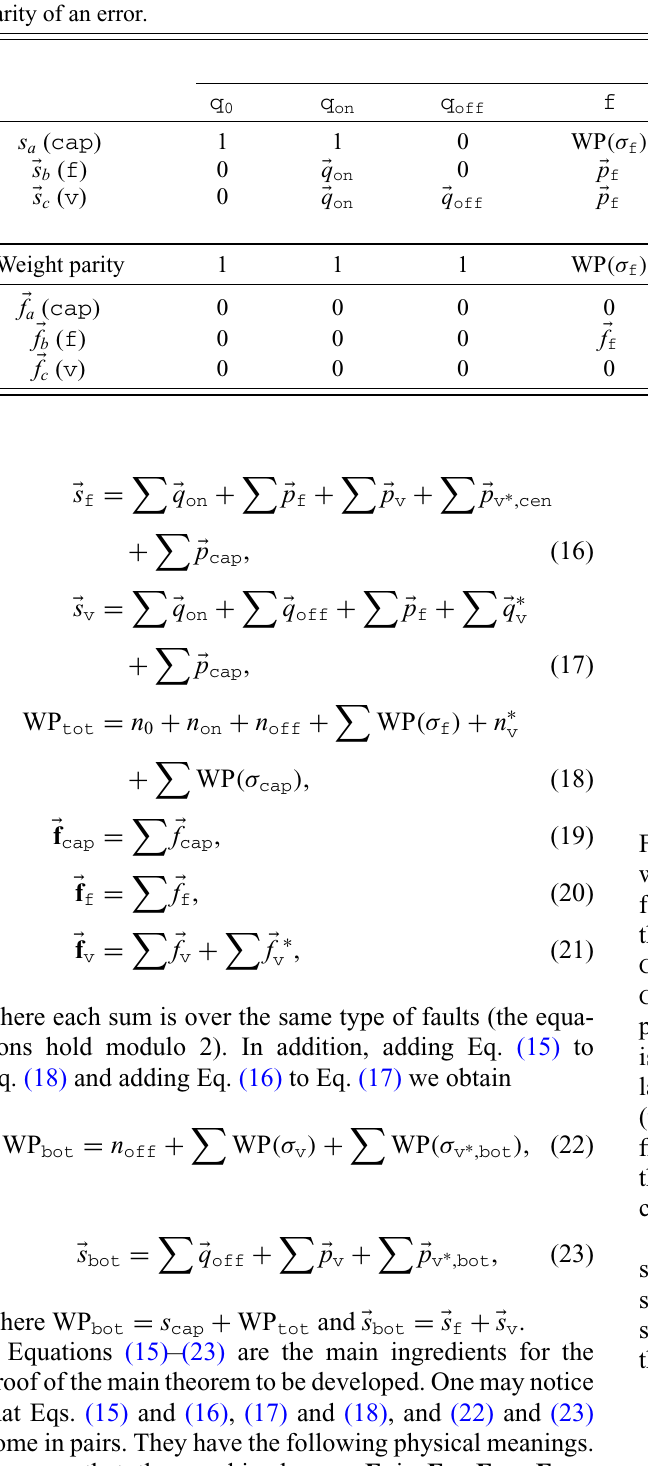
(cid:6) (cid:6) (cid:6) f a , f b , f c are flag outcomes